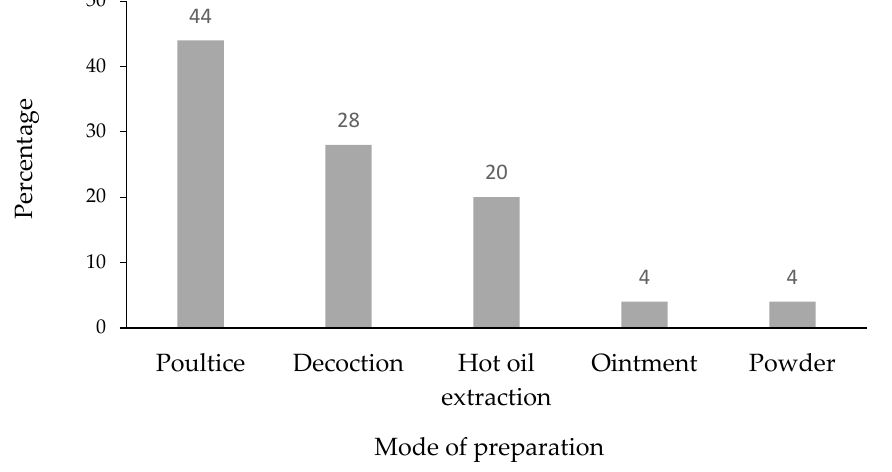
Figure 2. Mode of preparation of polyherbal prescriptions used by traditional healers.